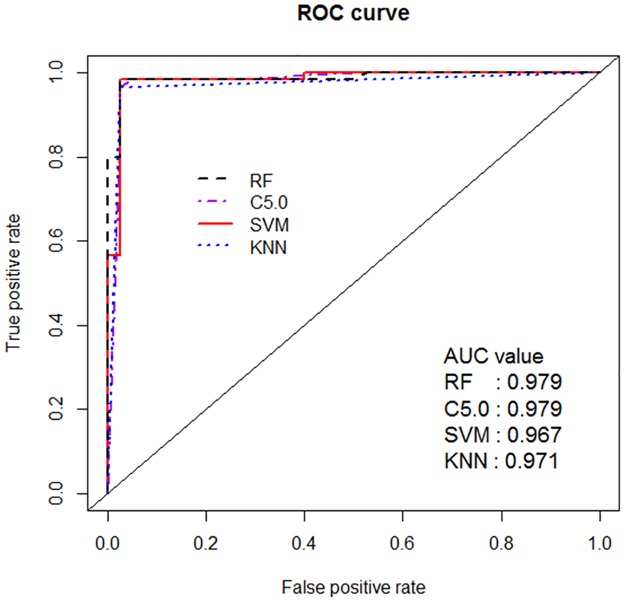
ROC curve and AUC for four models.AUC expresses global quality of prediction models and RF and C5.0 models show 0.979, SVM is over 0.967, and KNN is 0.971. All models show very high values near 1.0.